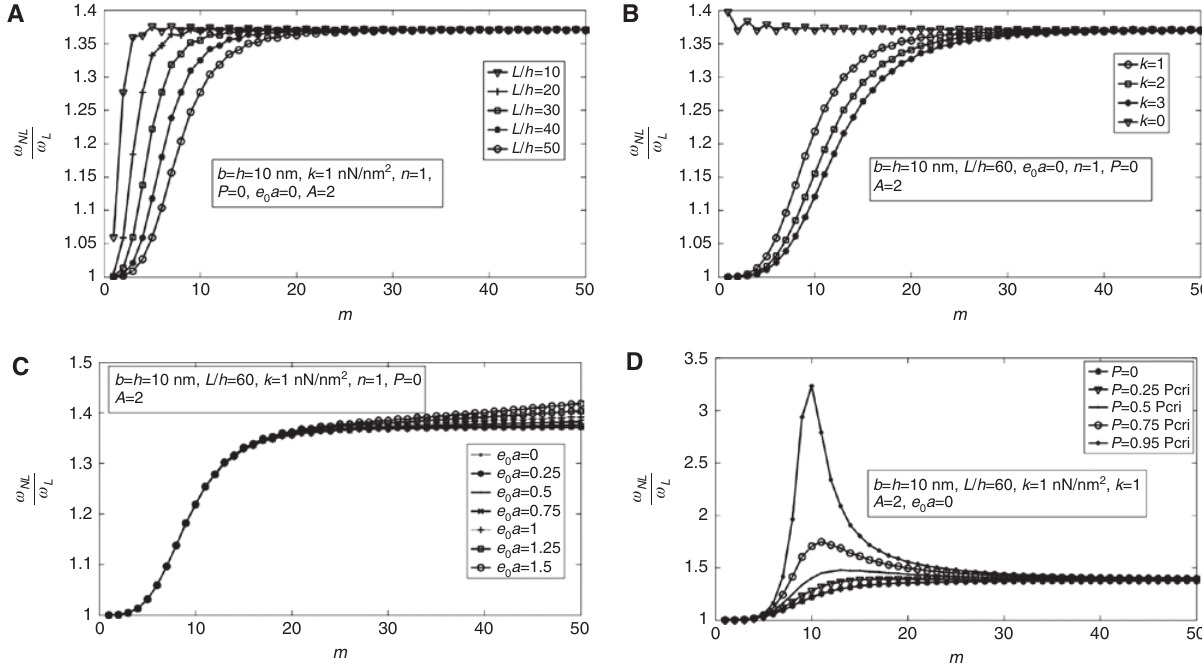
Figure 7: Effect of (A) aspect ratio, (B) elastic foundation, (C) small scale, and (D) precompressive axial force on the nonlinear to linear frequency ratio of FG